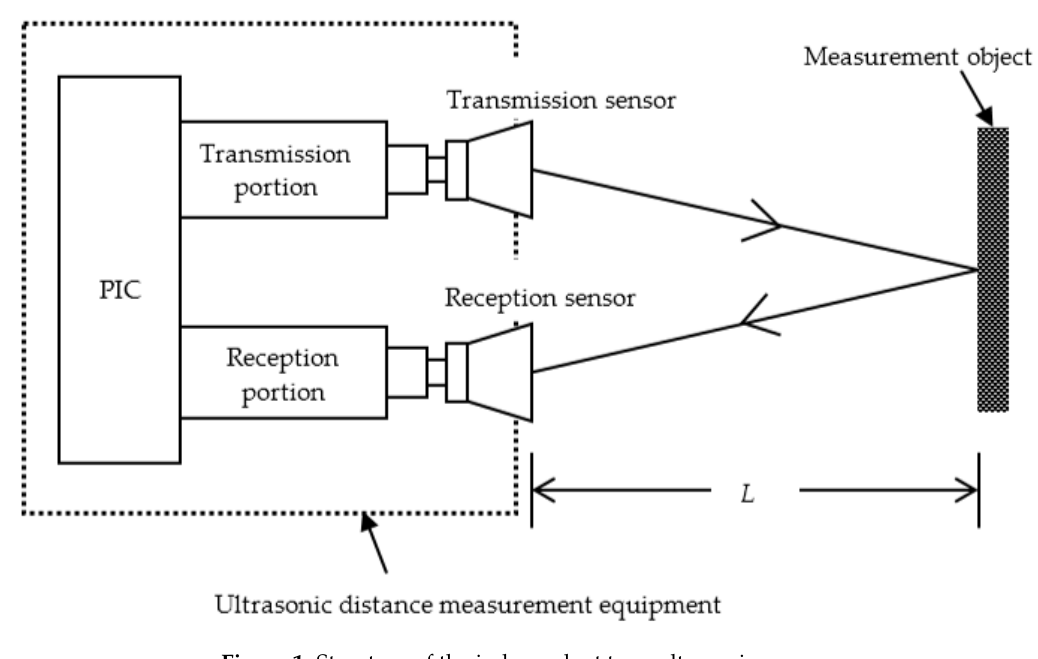
Figure 1. Structure of the independent type ultrasonic sensor.